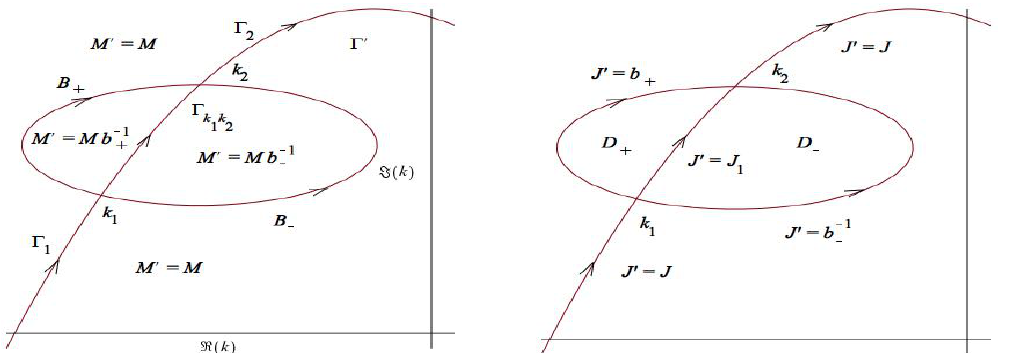
Figure 7. Deformation of a RH